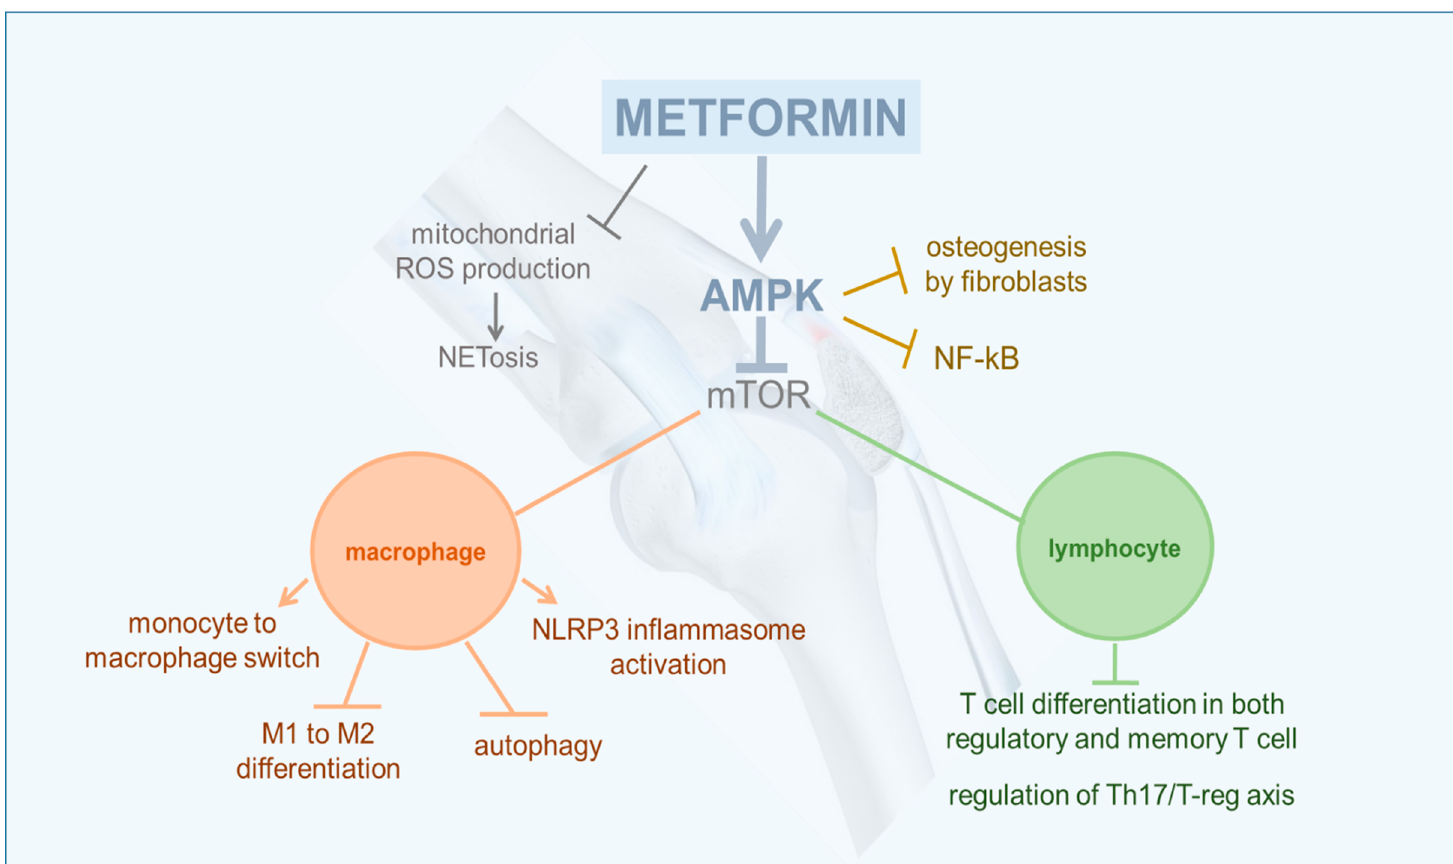
Figure 1. Simplified scheme of anti-inflammatory and immunomodulating effects of metformin.